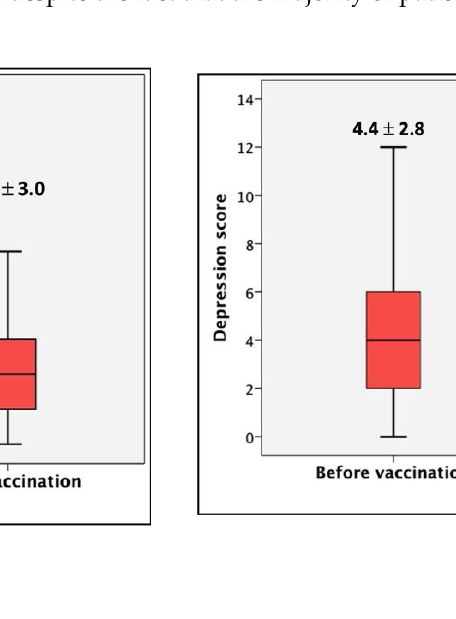
Figure 1. ( a ) Descriptive anxiety results in the HADS test in all participants before and after COVID- 19 vaccination. Chi-square test p = 0.05. ( b ) Descriptive depression results in the HADS test in all participants before and after COVID-19 vaccination. Chi-square test p = 0.80. After vaccination: two weeks after the second dose of vaccination.